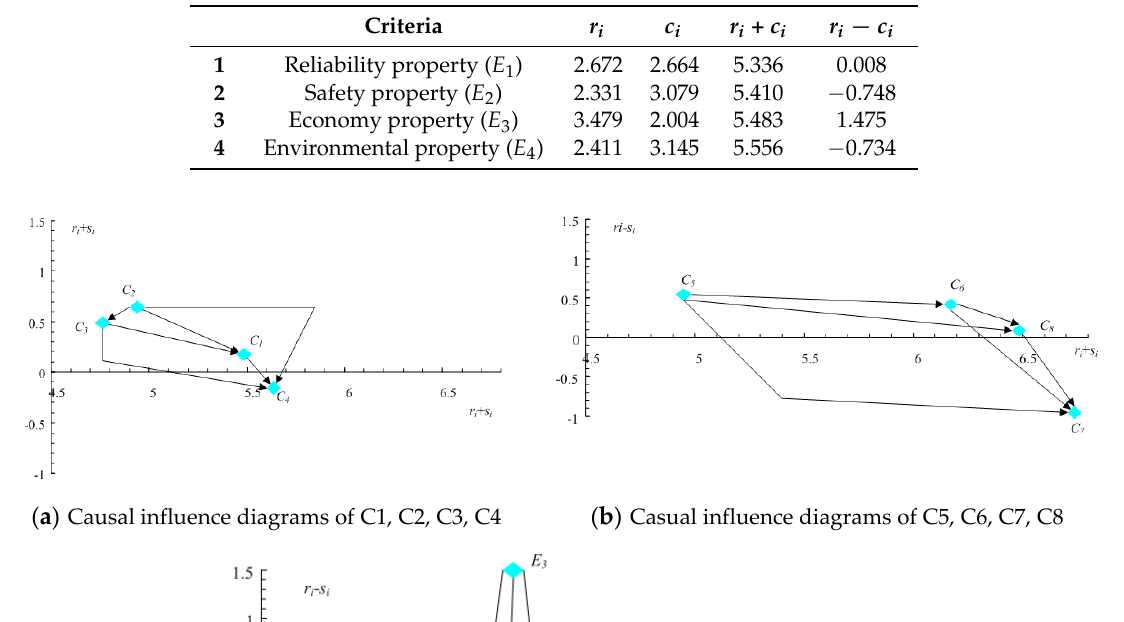
Table 5. Sum of influences given and received on dimensions.